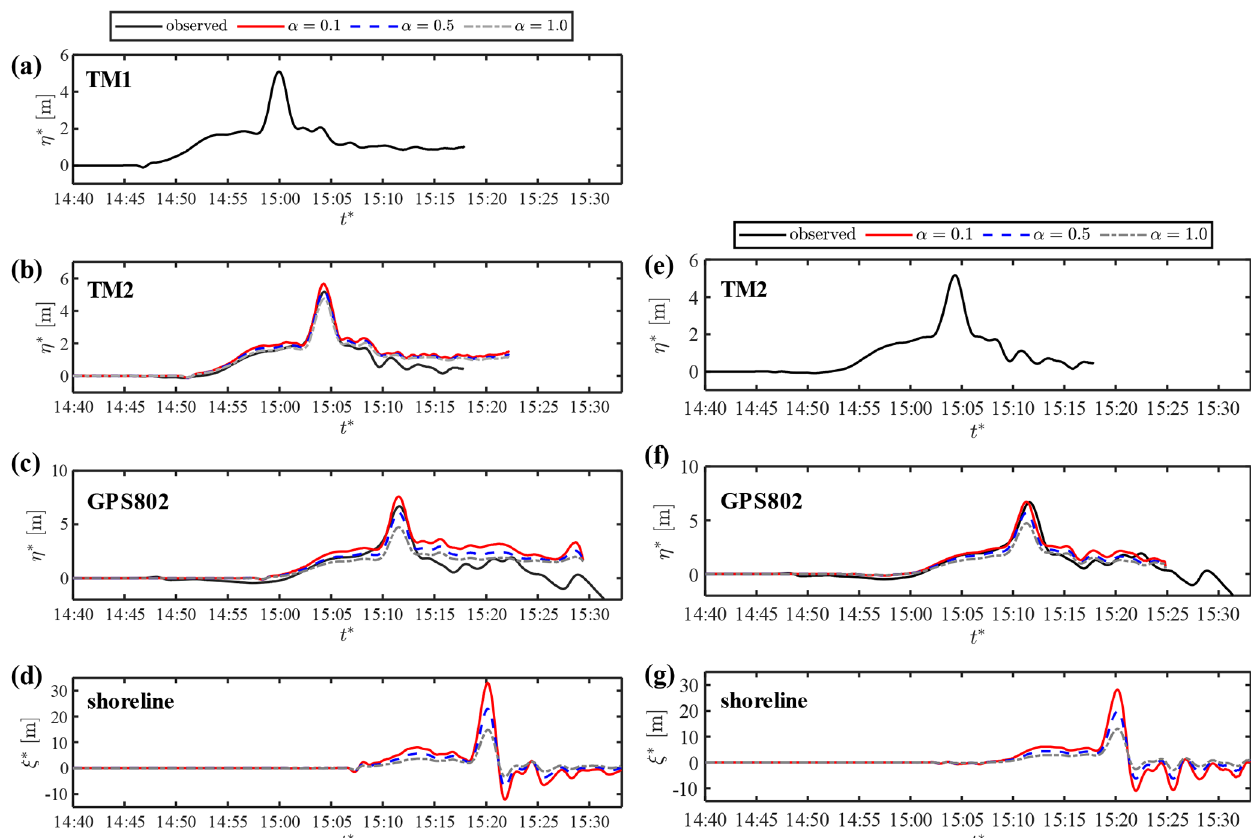
Figure 9. Prediction of coastal waveforms in Case 2: (a) observed-wave data at TM1, (b) predicted waveforms based on TM1 and observed wave at TM2, (c) predicted waveforms based on TM1 and observed wave at GPS802, (d) predicted shoreline motion based on TM1, (e) observed-wave data at TM2, (f) predicted wave based on TM2 and observed wave at GPS802, and (g) predicted shoreline motion based on